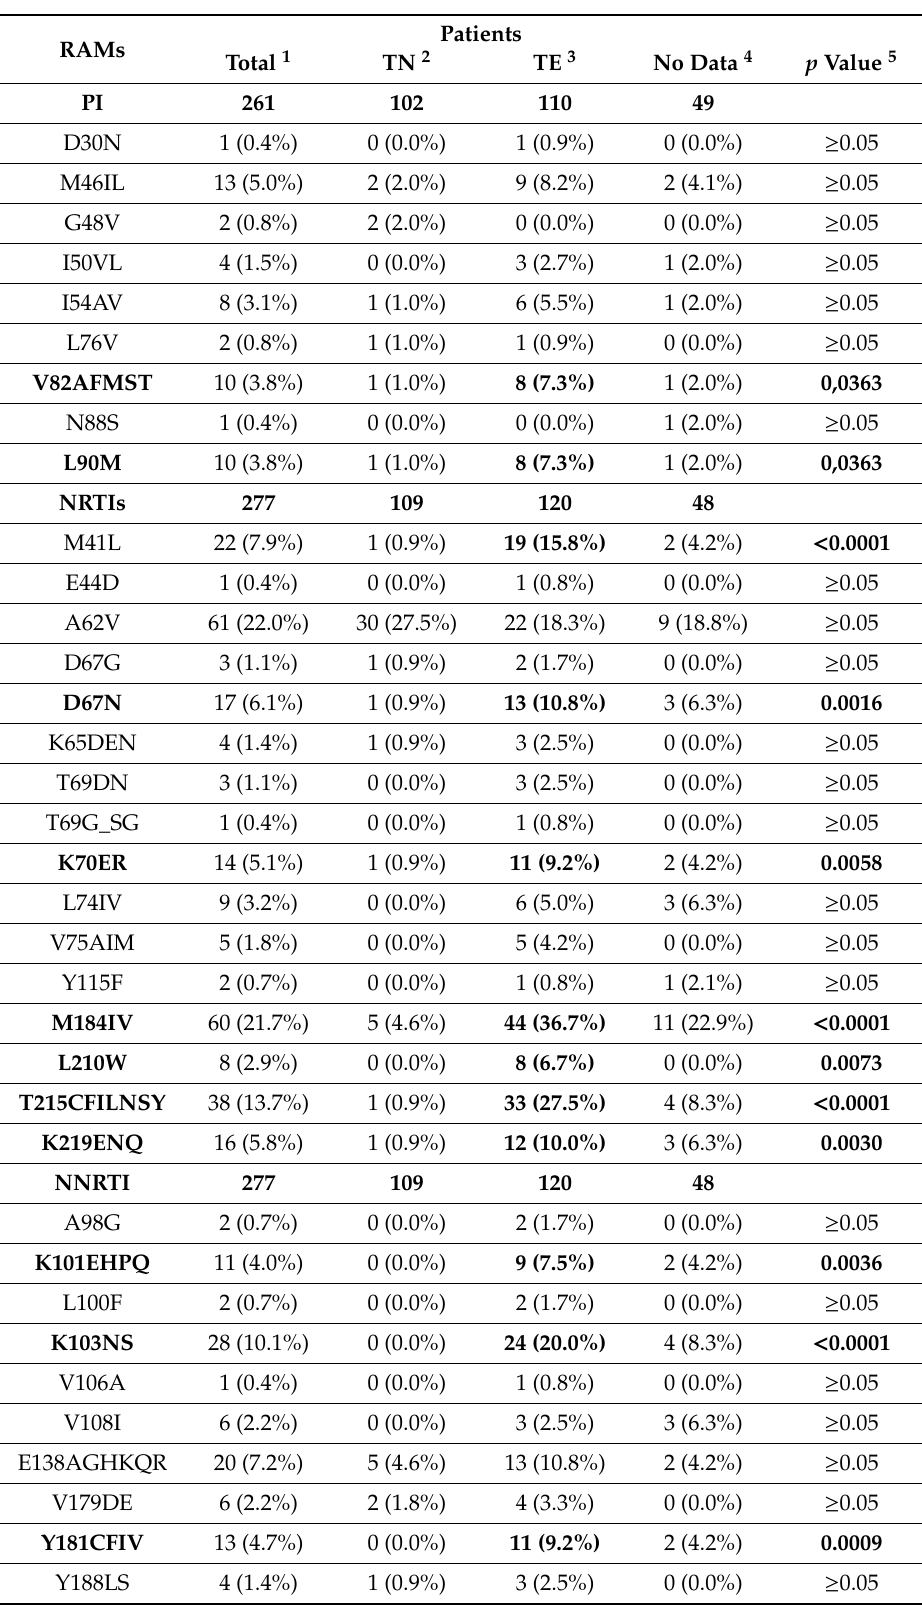
Table 1. Resistance-associated-mutations (RAMs) detected in the protease (PR), reverse transcriptase (RT) and integrase (IN) sequences according to antiretroviral